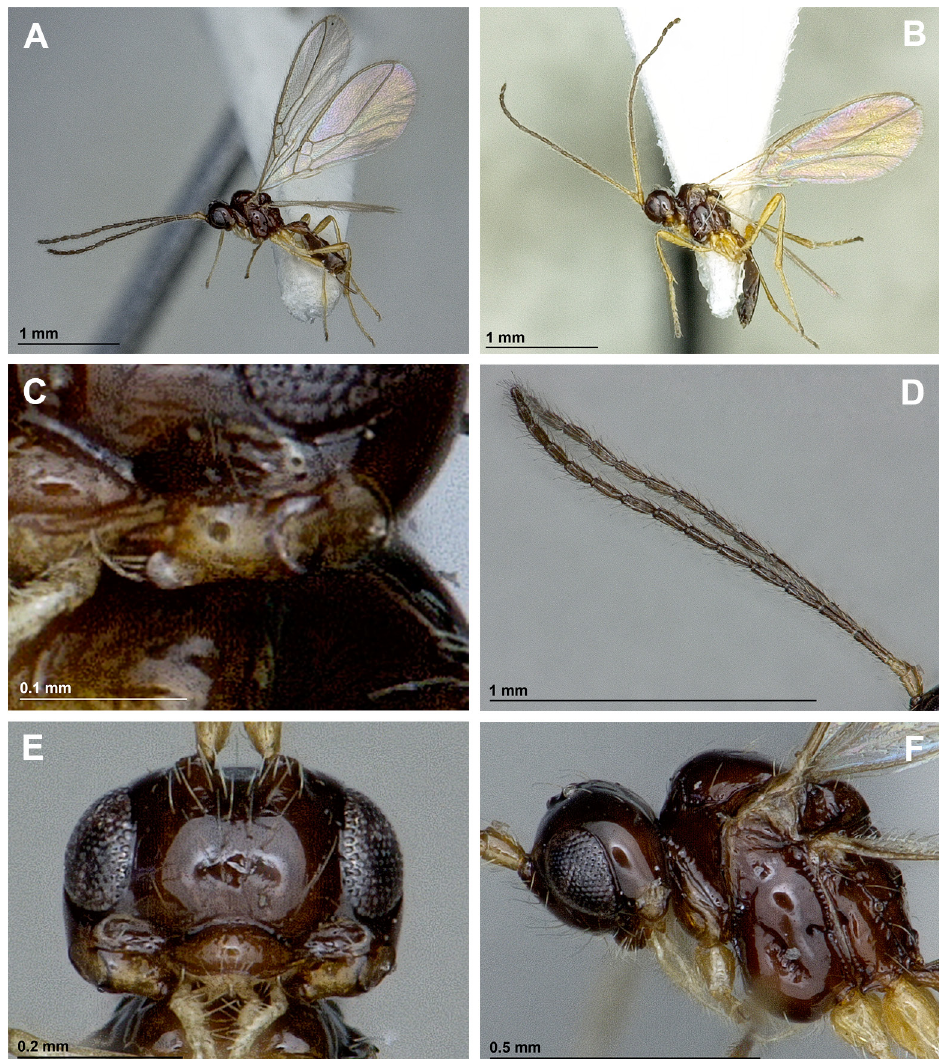
Fig. 4. Aspilota leptoarticulata Munk & Peris-Felipo sp. nov. (A, C–F ♀; B ♂). A–B . Habitus, lateral view. C . Mandible. D . Antennae. E . Head, frontal view. F . Head and mesosoma, lateral